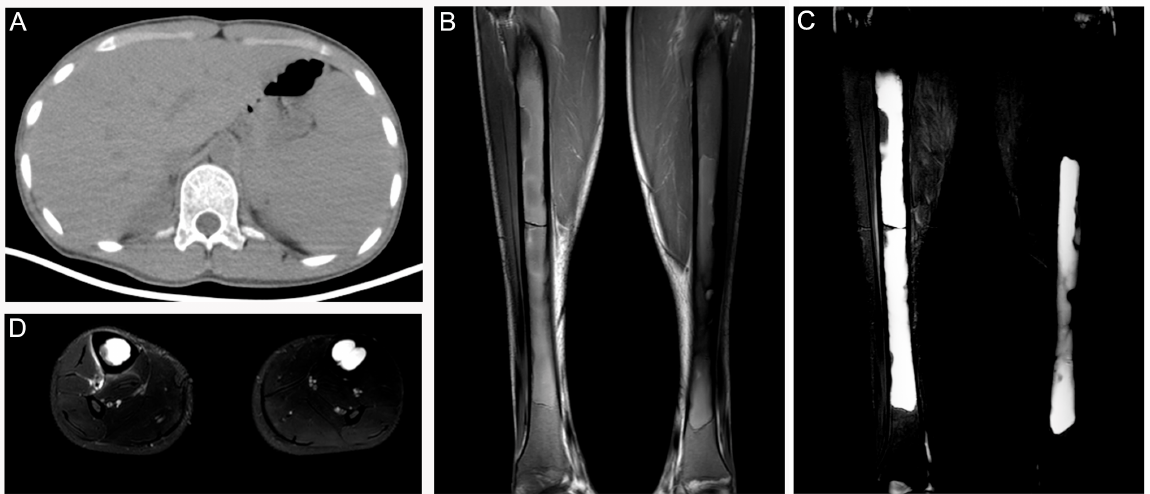
Figure 1. Patient 1: ( A ) Axial CT demonstrated marked hepatosplenomegaly. ( B ) Coronal T1 WI image following CT examination demonstrated low SI in the diaphyses of the femora extending to extremities. ( C , D ) There was high SI in these areas on coronal and axial STIR images with confined edges.